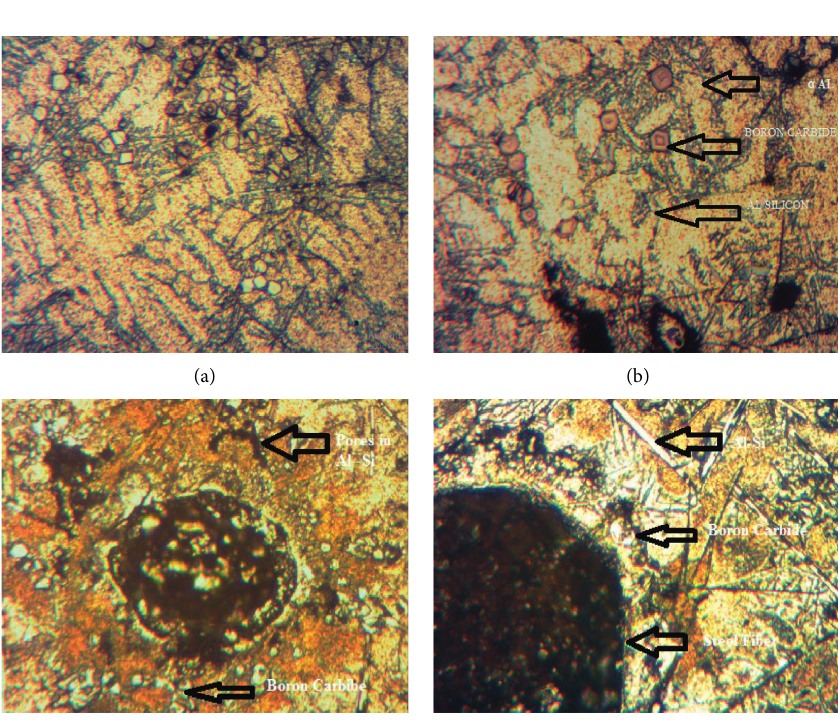
Figure 6: (a, b) Optical micrographs of LM6 Al alloy hybrid composites with 5% of B of CCSF and 5% of B 4 C.